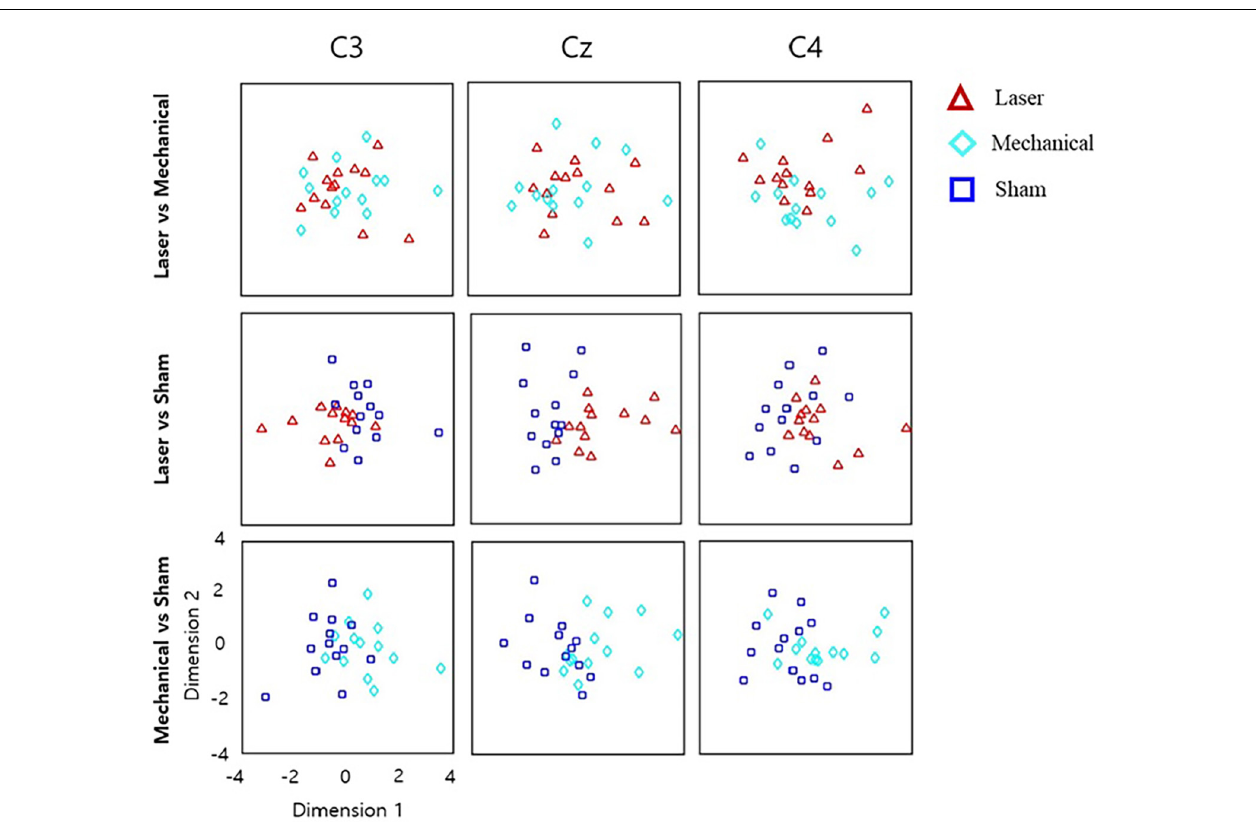
FIGURE 5 | Low-dimensional representations of EEG responses to different stimuli, reduced by non-metric multidimensional scaling (NMDS). The original, high-dimensional EEG features at each channel were reduced to the two dimensional space. Each point corresponds to the 2D representation of the significant time–frequency EEG responses averaged over the trials in response to a given stimulus in each subject. Note that in the same channel, the 2D representations of EEG responses to a stimulus (e.g., laser) differed for different pairs (e.g., laser-mechanical and laser-sham) because the original time–frequency EEG responses selected for each stimulus pair varied by different statistical results (see the text). The horizontal axis denotes the first dimension reduced by NMDS, and the vertical axis denotes the second